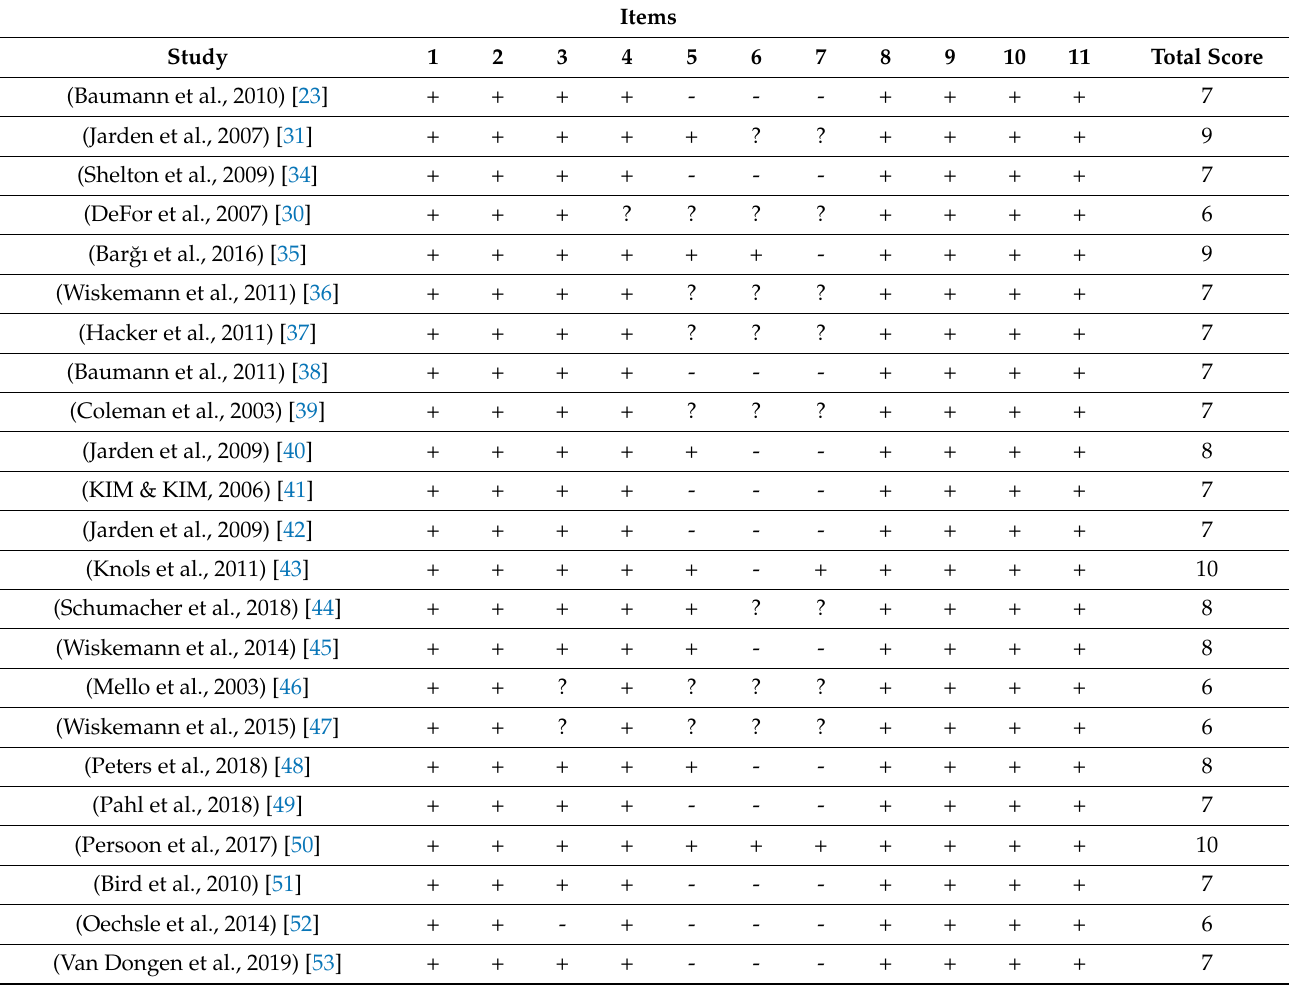
Table 1. Quality of the studies included in the systematic